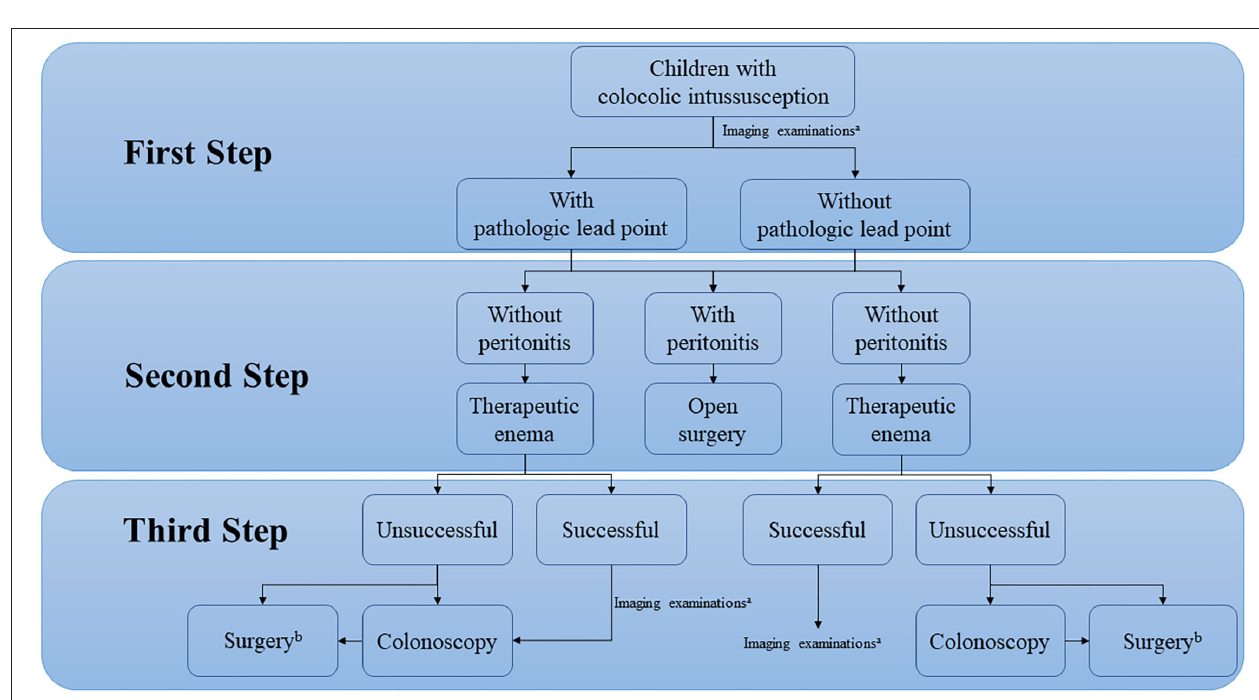
FIGURE 3 | Recommended algorithm for the management of colocolic intussusception in children. a Ultrasound is preferred, combined with other imaging examinations when necessary. b Laparoscopy can be used for exploration and open surgery is recommended as the primary surgical procedure.